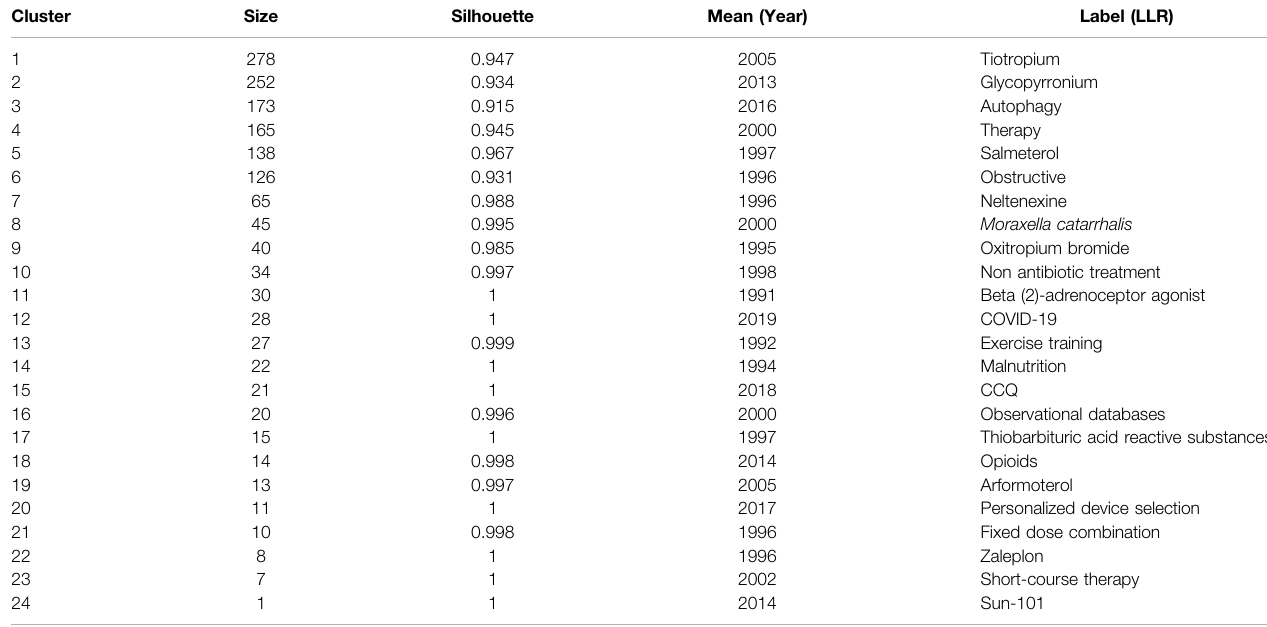
TABLE 4 | Co-citation clustering of COPD drugs-related studies that were published from 1980 to 2021. Cluster